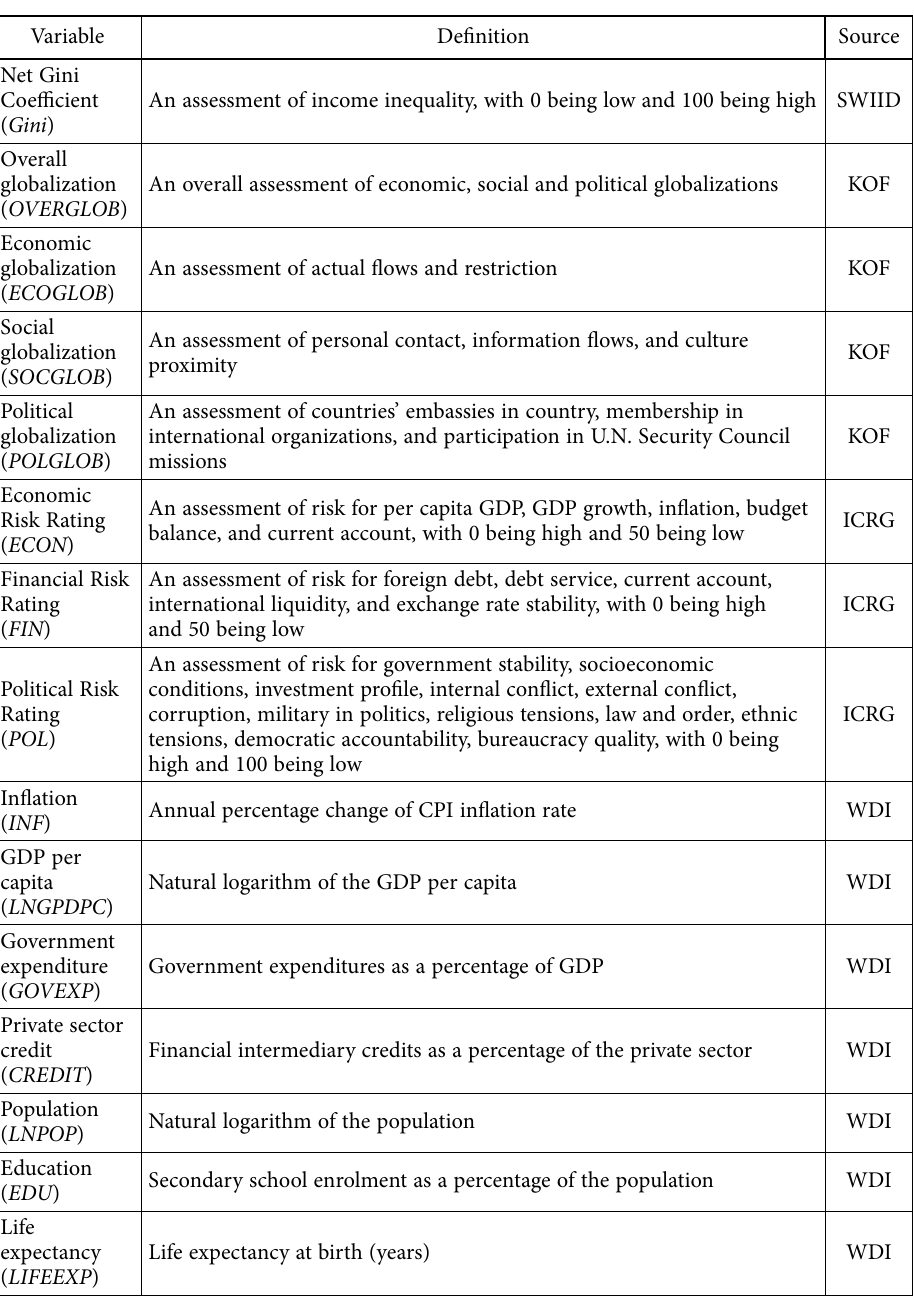
Table A4. List of variables, definitions and data sources